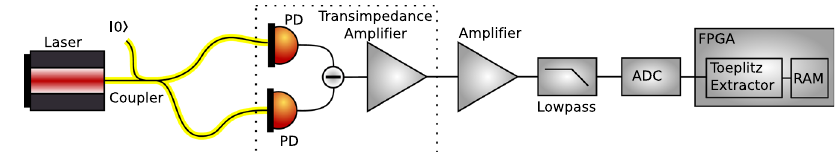
Fig. 1 Schematic of the quantum random number generator. A 1.6 mW 1550 nm laser beam was split into two by a 3 dB fi ber coupler and detected by a home-made homodyne detector based on an MAR-6 microwave ampli fi er from Minicircuits and two 120 μ m indium – gallium – arsenide photo diodes (PD). The output of the detector was ampli fi ed with another microwave ampli fi er, low pass fi ltered at 400 MHz, and digitized with a 16 bit 1-GSample/s analog- to-digital converter (ADC). The ADC output was read by a Xilinx Kintex UltraScale fi eld-programmable gate array (FPGA). The ADC and FPGA were hosted by a PCI Express card from 4DSP (Abaco). The FPGA was used for real-time randomness extraction based on Toeplitz hashing. Random access memory (RAM) was used to store the